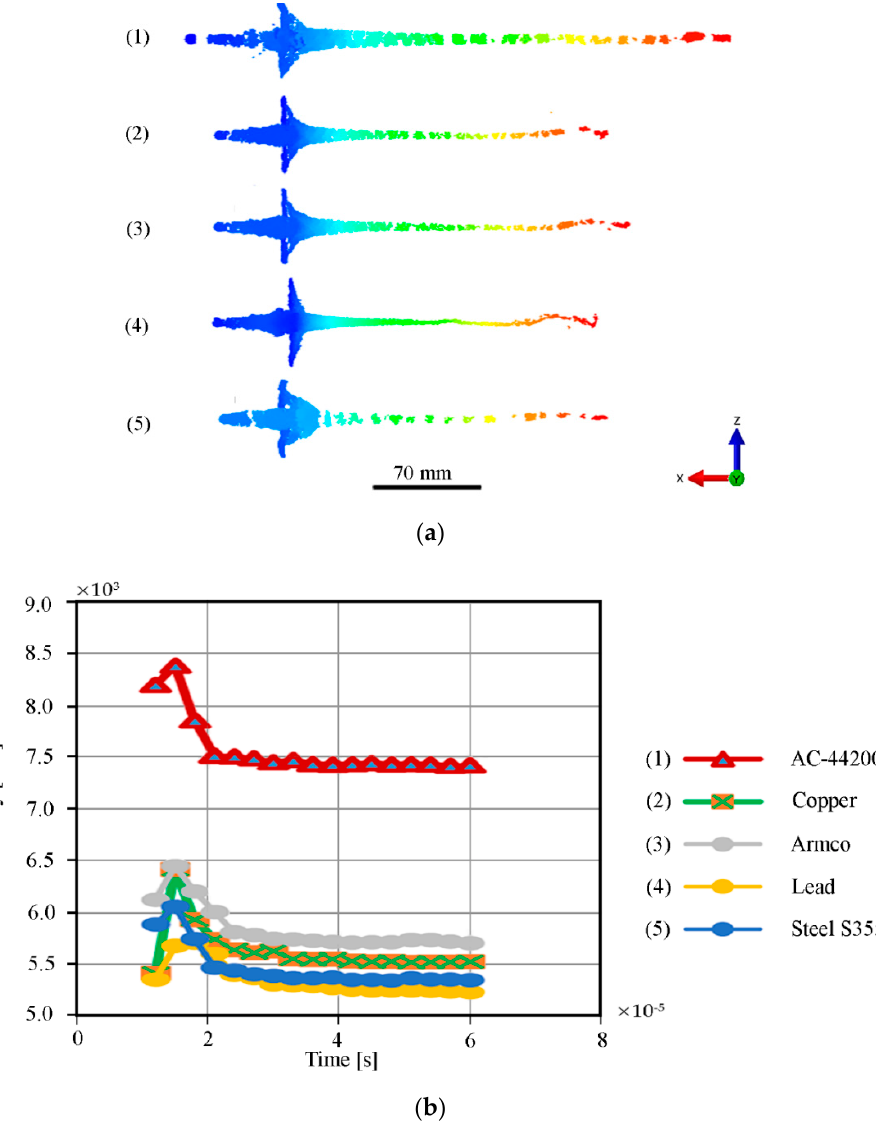
Figure 17. Simulations of cumulative charges with liners of different material structures: ( a ) formation of the cumulative jet; ( b ) jet velocities for different insert materials.